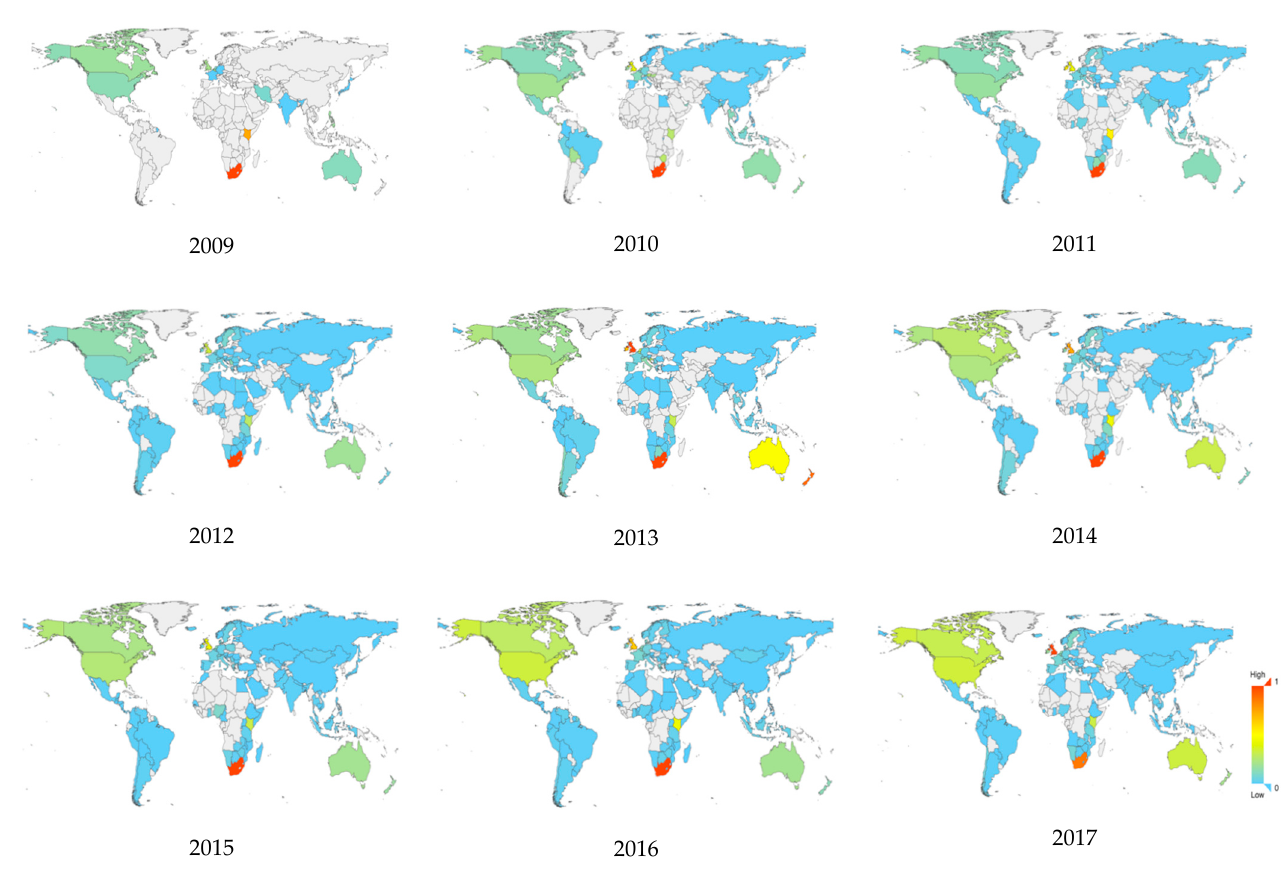
Figure 11. Geographical distribution of negative emotional index.